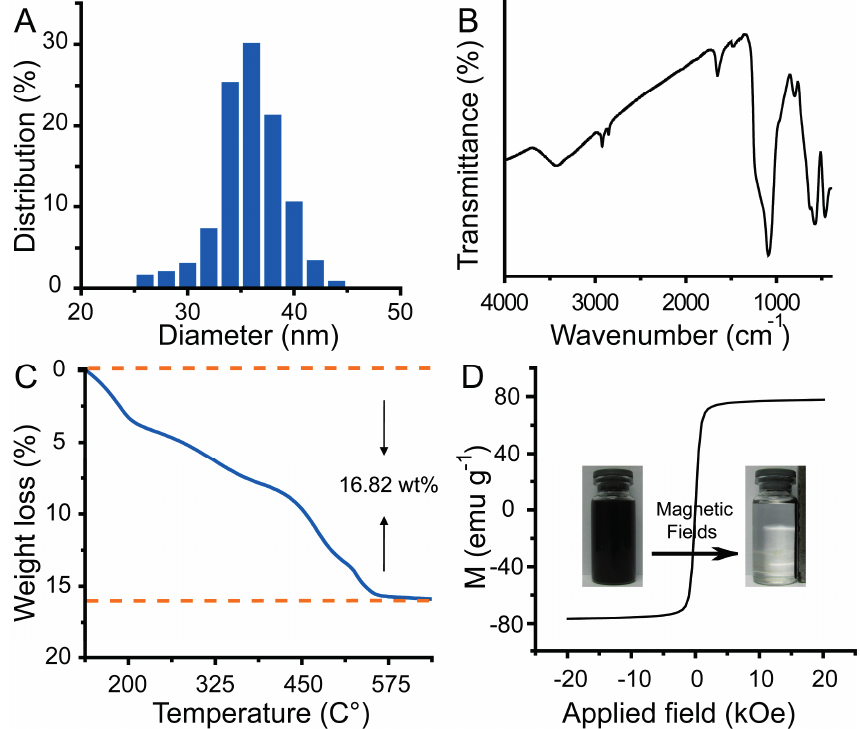
Figure 3. Size distribution ( A ); Fourier transform infrared spectroscopy (FT-IR) spectrum ( B ); Thermalgravimetric analysis (TGA) ( C ); hysteresis loop ( D ); and magnetic separation photo (inset of ( D )) of PEG–Fe 3 O 4 .